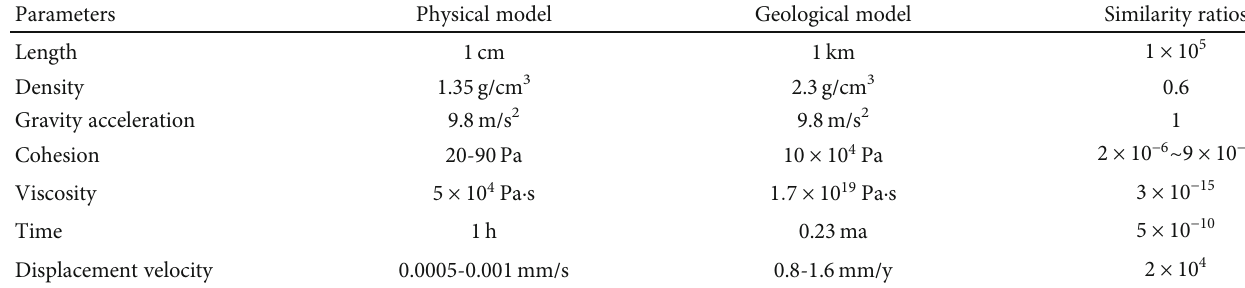
Table 2: Parameters of experimental materials.